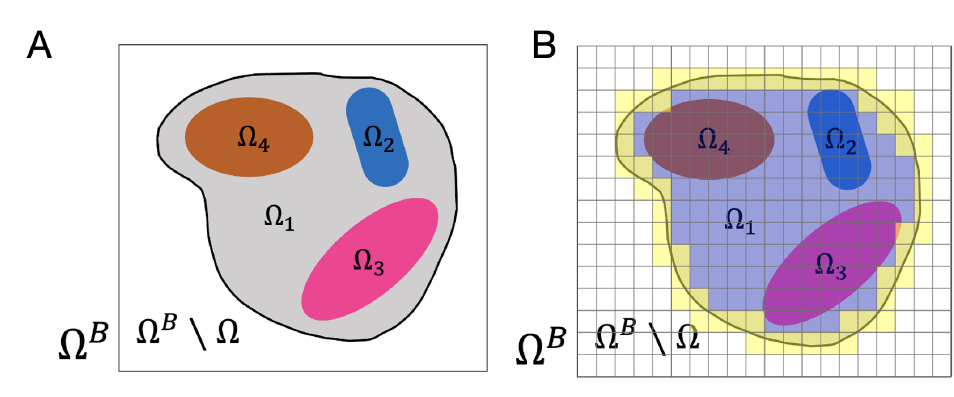
Figure 2. ( A ) The background domain Ω B and ( B ) (one of its possible) mesh T h ( Ω B ) (for more details regarding accurate estimations of the displacement fields at the interfaces, see Section 2.4). Inner and cut (by ∂ Ω ) elements T ∈ T h are in blue and yellow,